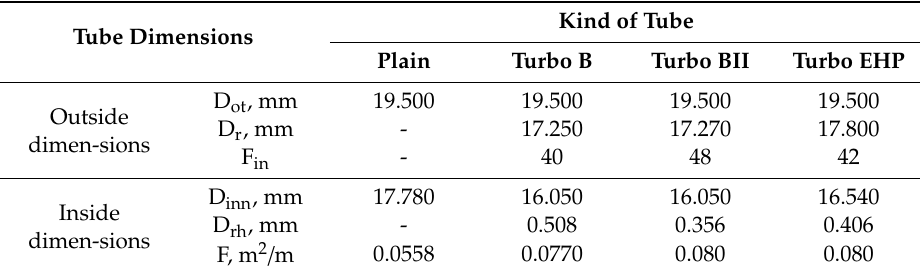
Table 1. The dimensions of the tubes applied in the large falling film evaporator [38].